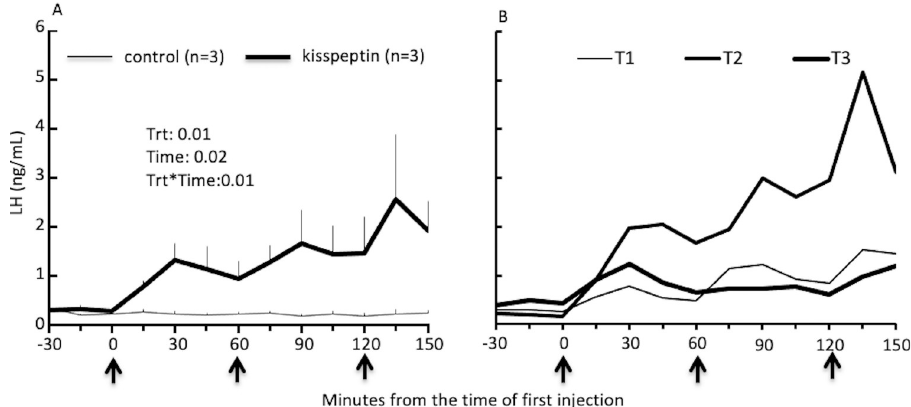
Fig 2. Plasma LH concentration in the experiment 1. A) Plasma LH plasma concentrations in lactating cows treated with three iv injections of 15mg human Kisspeptin-10 (kisspeptin; n = 3) or normal saline (control; n = 3) at 1h intervals on Day 7 (Day 0 = day of wave emergence) in Experiment 1. B) Plasma LH profiles of individual cows from the kisspeptin group illustrating similar pattern in two cows but varying magnitude of response among the three animals. Black arrows along the x-axes indicate the time of